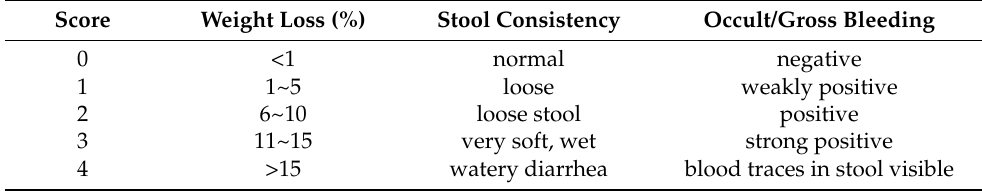
Table 1. DAI evaluation